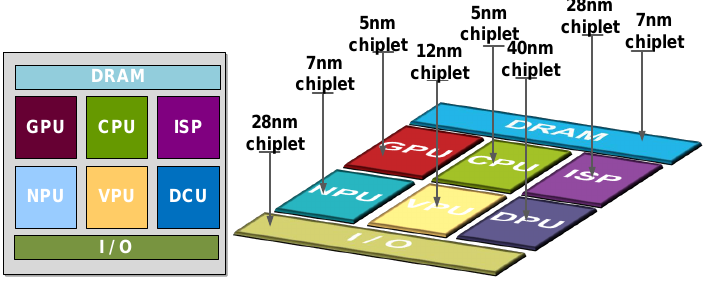
Figure 1. Chips interconnection of different processes.